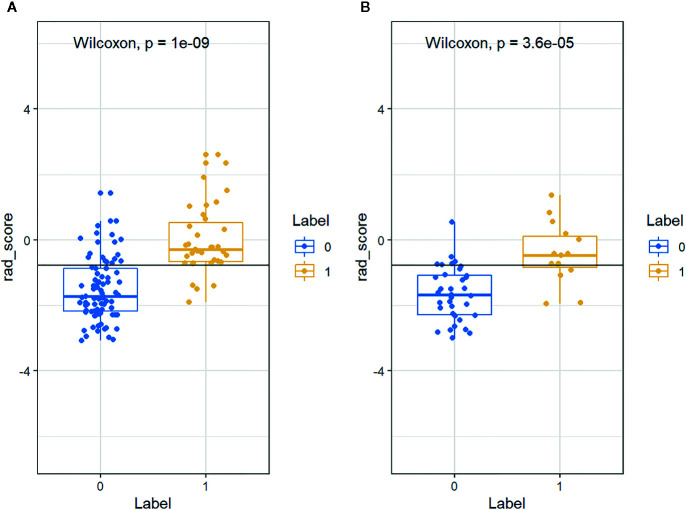
The distributions of the Rad-score for each patient in the (A) training and (B) validation cohorts. Blue and yellow represent non-aggressive clear cell renal cell carcinoma (ccRCC) and aggressive ccRCC, respectively.